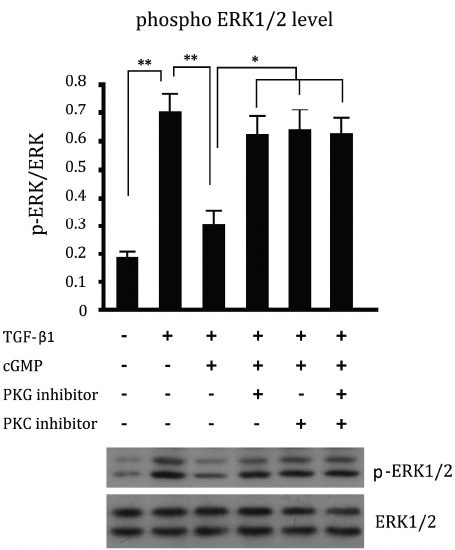
Figure 5. Cross talk effects between PKC inhibitor and cGMP pathway. The concentrations of ERK1/2 were expressed as gray scale. The phosphorylation levels of ERK1/2 were expressed as the ratio of gray scale of p-ERK/ERK. The phosphorylation level of ERK1/2 was remarkably increased in cells incubated with TGF- β 1. The increased phosphorylation level of ERK1/2 was down-regulated by cGMP in 10 ng/mL. And the effect of decreased phosphorylation level of ERK1/2 was abrogated by PKG inhibitor and PKC inhibitor. ** p < 0.01 and * p < 0.05.